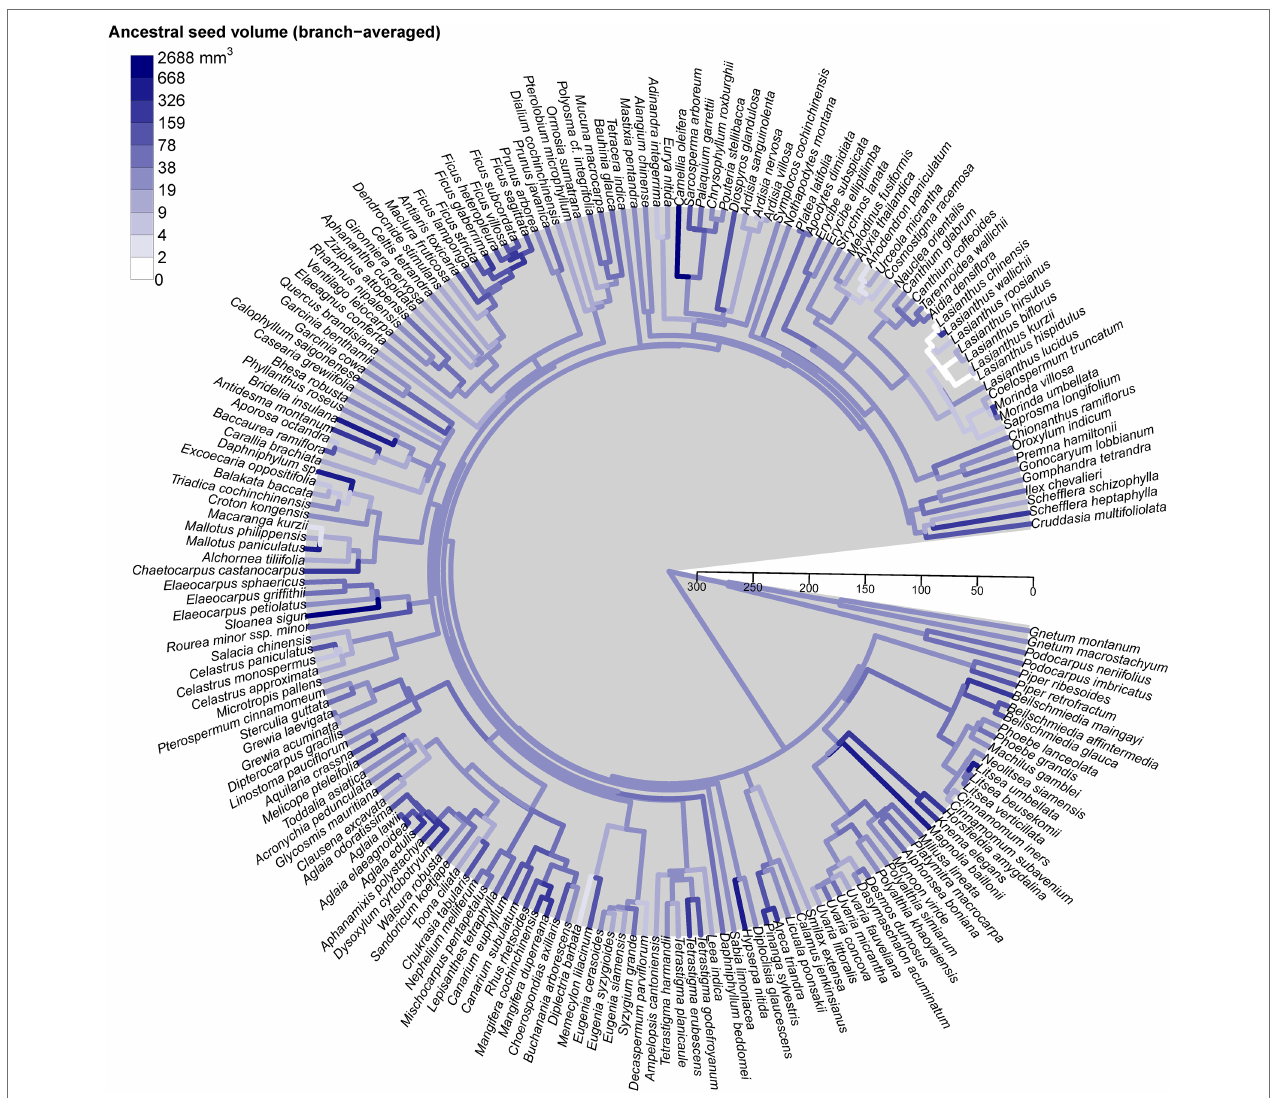
FIGURE 4 | Phylogenetic tree of the 196 species found in Mo Singto plot, illustrating the evolution of mean seed size (seed volume, mm 3 ). The ancestral states of this trait were reconstructed under a model of Brownian motion fitted by residual maximum likelihood (REML); the values between the two nodes of each branch were averaged to define the color as shown on the plot. The time scale units are Ma (ranging from 0 to 300